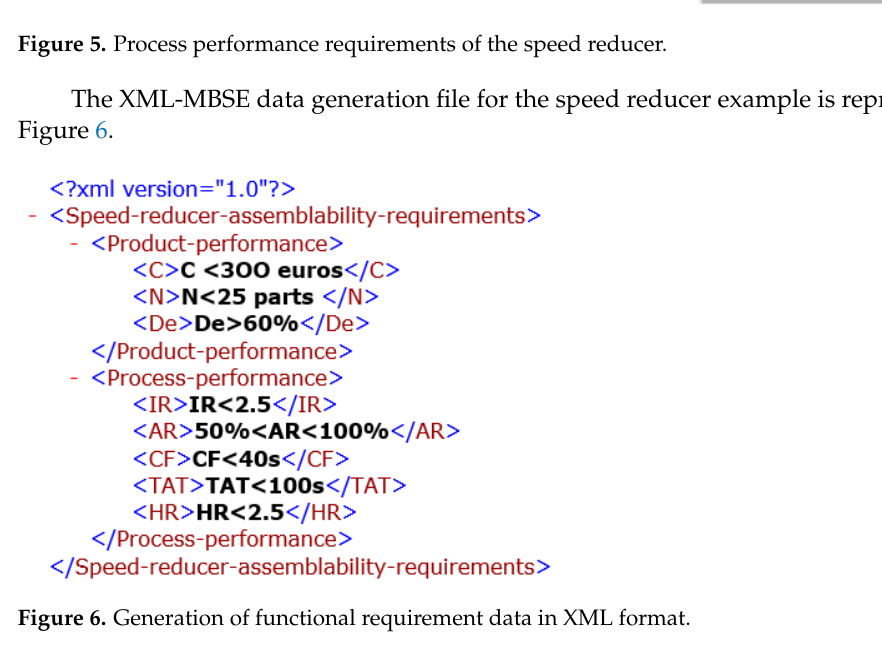
Figure 6. Generation of functional requirement data in XML format .